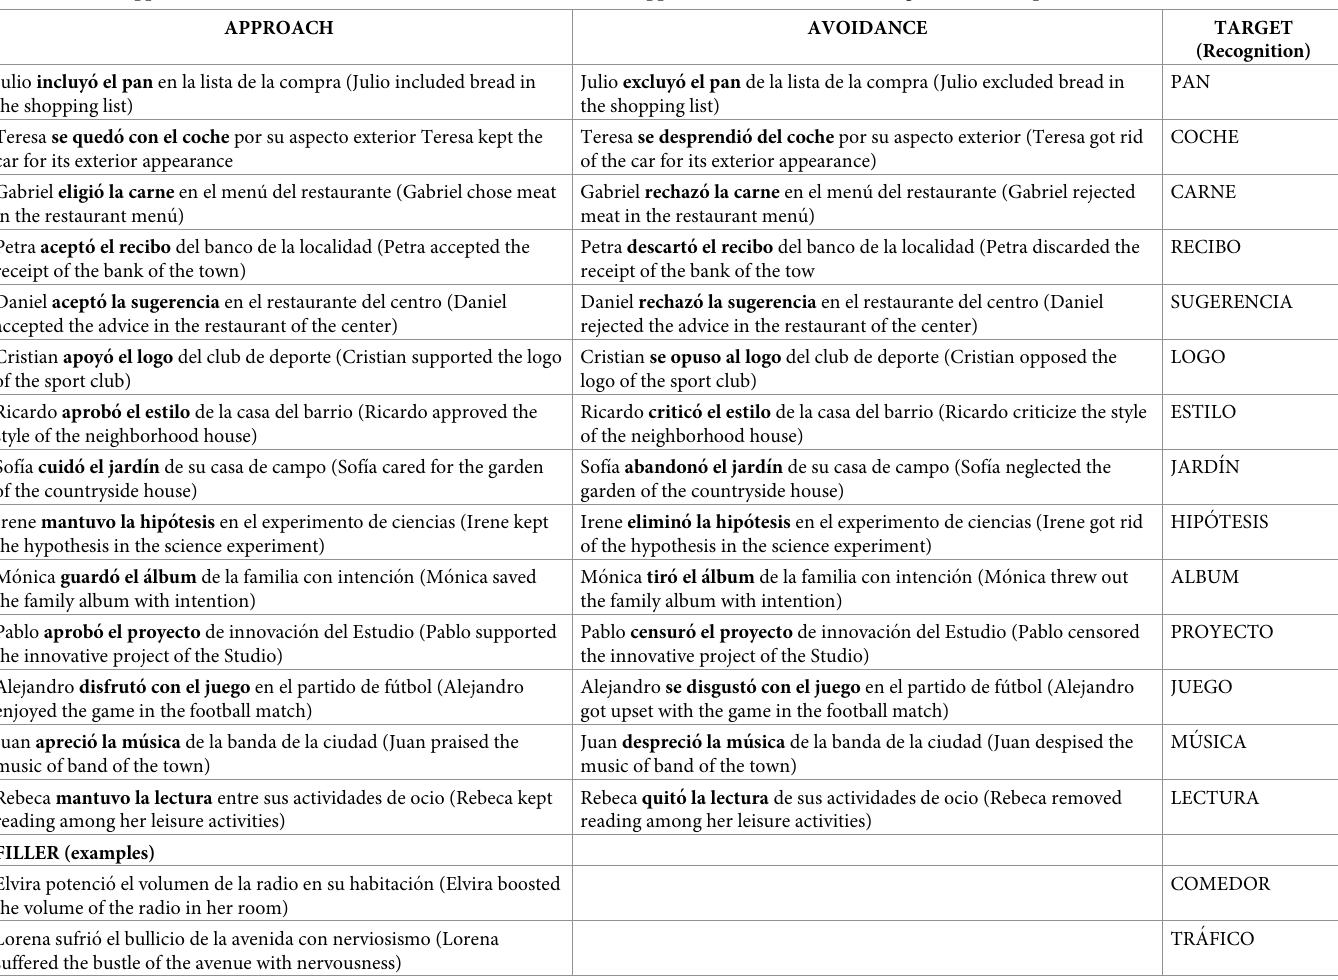
Table 2. List of approach and avoidance sentences in affirmative version with approximate translation into English, and examples of filler sentences.